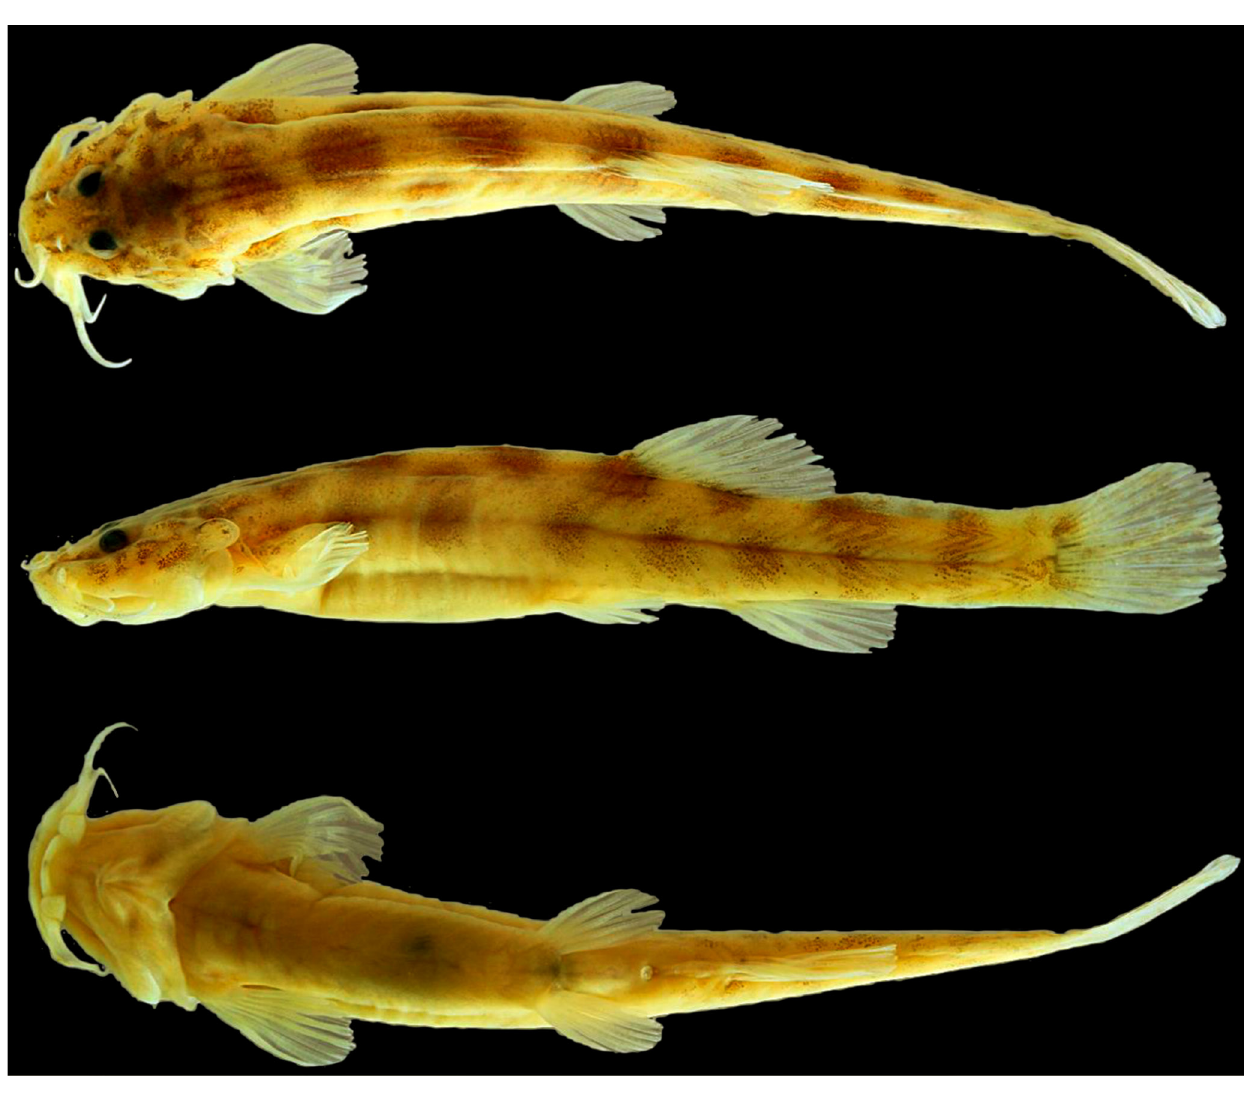
FIGURE 17 | Scleronema minutum (MCP 17514; 39.8 mm SL), Brazil, Rio Grande do Sul, São Lourenço do Sul, arroio São Lourenço, laguna dos Patos